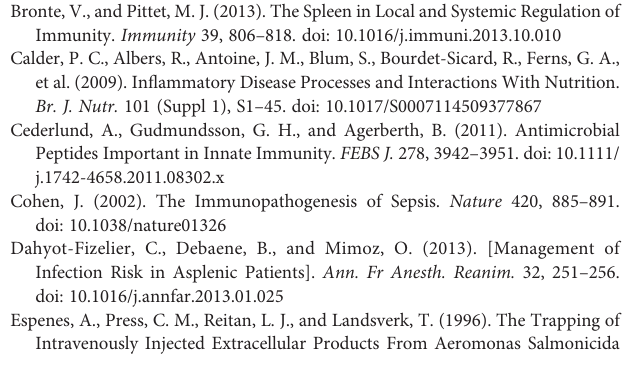
Supplementary Figure 2 | The number of DEGs for different groups. WT-0h, WT zebra fi sh without vaccination; Mut-0h, congenitally asplenic zebra fi sh without vaccination; WT-6h, WT zebra fi sh with vaccination sampled at 6 h; Mut-6h, congenitally asplenic zebra fi sh with vaccination sampled at 6 h; WT-10d, WT zebra fi shwithvaccinationsampled at10d;Mut-10d, congenitally aspleniczebra fi sh with vaccination sampled at 10 d. Supplementary Figure 3 | The DEGs involved in the TNF signaling pathway were annotated by KEGG in Mut-6h_vs_Mut-0h. Supplementary Figure 4 | The DEGs involved in the RIG-I-like receptor signaling pathway were annotated by KEGG in Mut-6h_vs_Mut-0h. Supplementary Figure 5 | The heat map with the expression pattern of in fl ammatory cytokines/chemokines at 0, 6 h and 10 d. Supplementary Figure 6 | The differentially expressed genes involved in the P53 signaling pathway were annotated by KEGG in Mut-6h_vs_Mut-0h. Supplementary Figure 7 | Expression pro fi les of IgZ and IgZ2 after vaccination in gill and skin. WT animals and congenitally asplenic zebra fi sh sampled at 0 h were used as controls. The data were normalized to the expression level of WT-0h. The data are reported as the mean ± SEM. Different letters (a, b, c, etc.) indicate signi fi cant differences ( p <